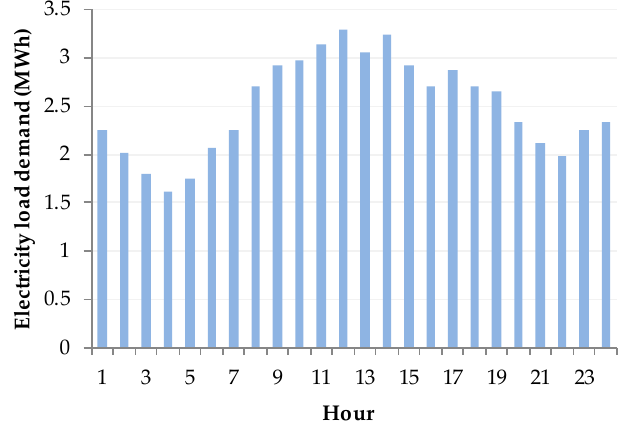
Figure A1. Load demand over a single day.